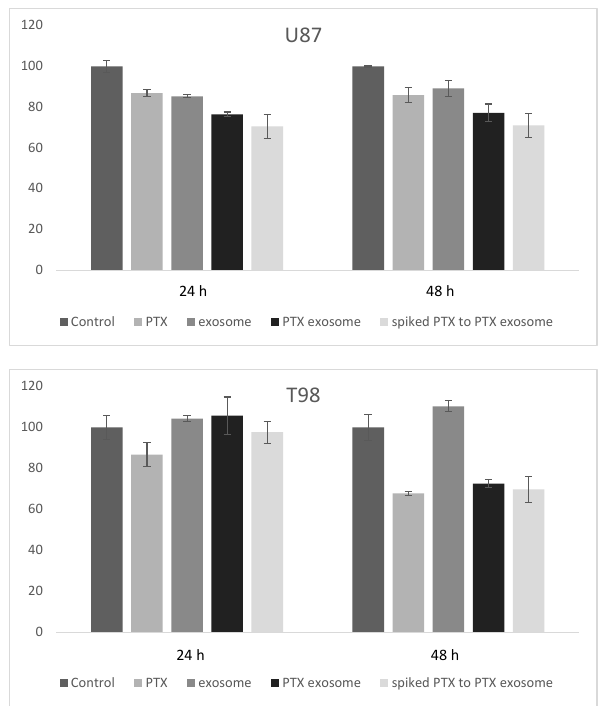
Fig. 4: Cytotoxicity plot of formulations on U87 and T98 cells